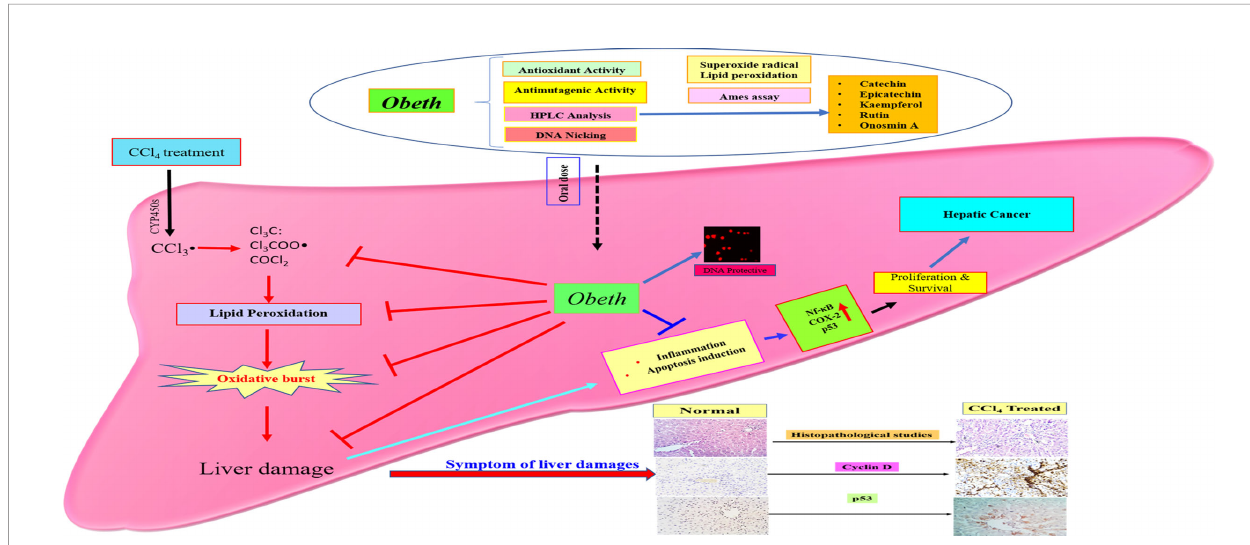
FIGURE 11 | Schematic proposed mechanisms for hepatoprotective property of Obeth from O. bracteata . Obeth phytoconstituents ameliorated hepatic oxidative stress and suppressed in fl ammation, apoptosis, and DNA damage in CCl 4 -injured